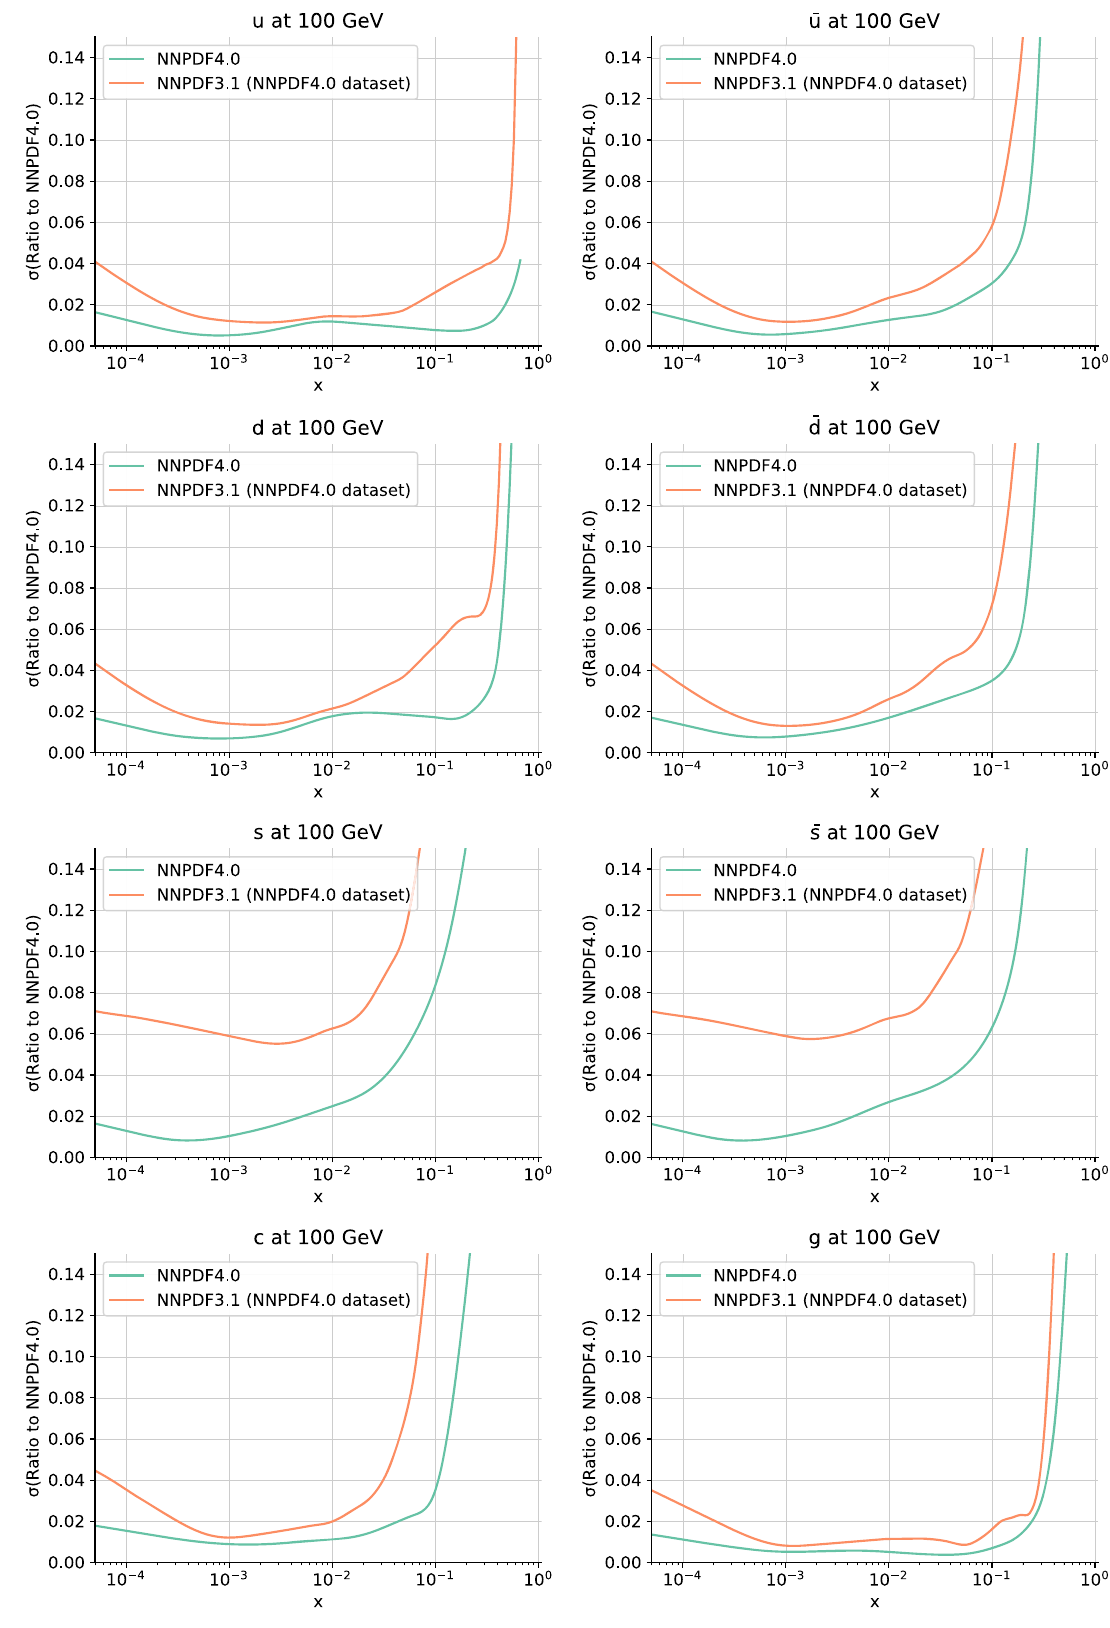
Fig. 46 Same as Fig. 45 but showing the one-sigma relative